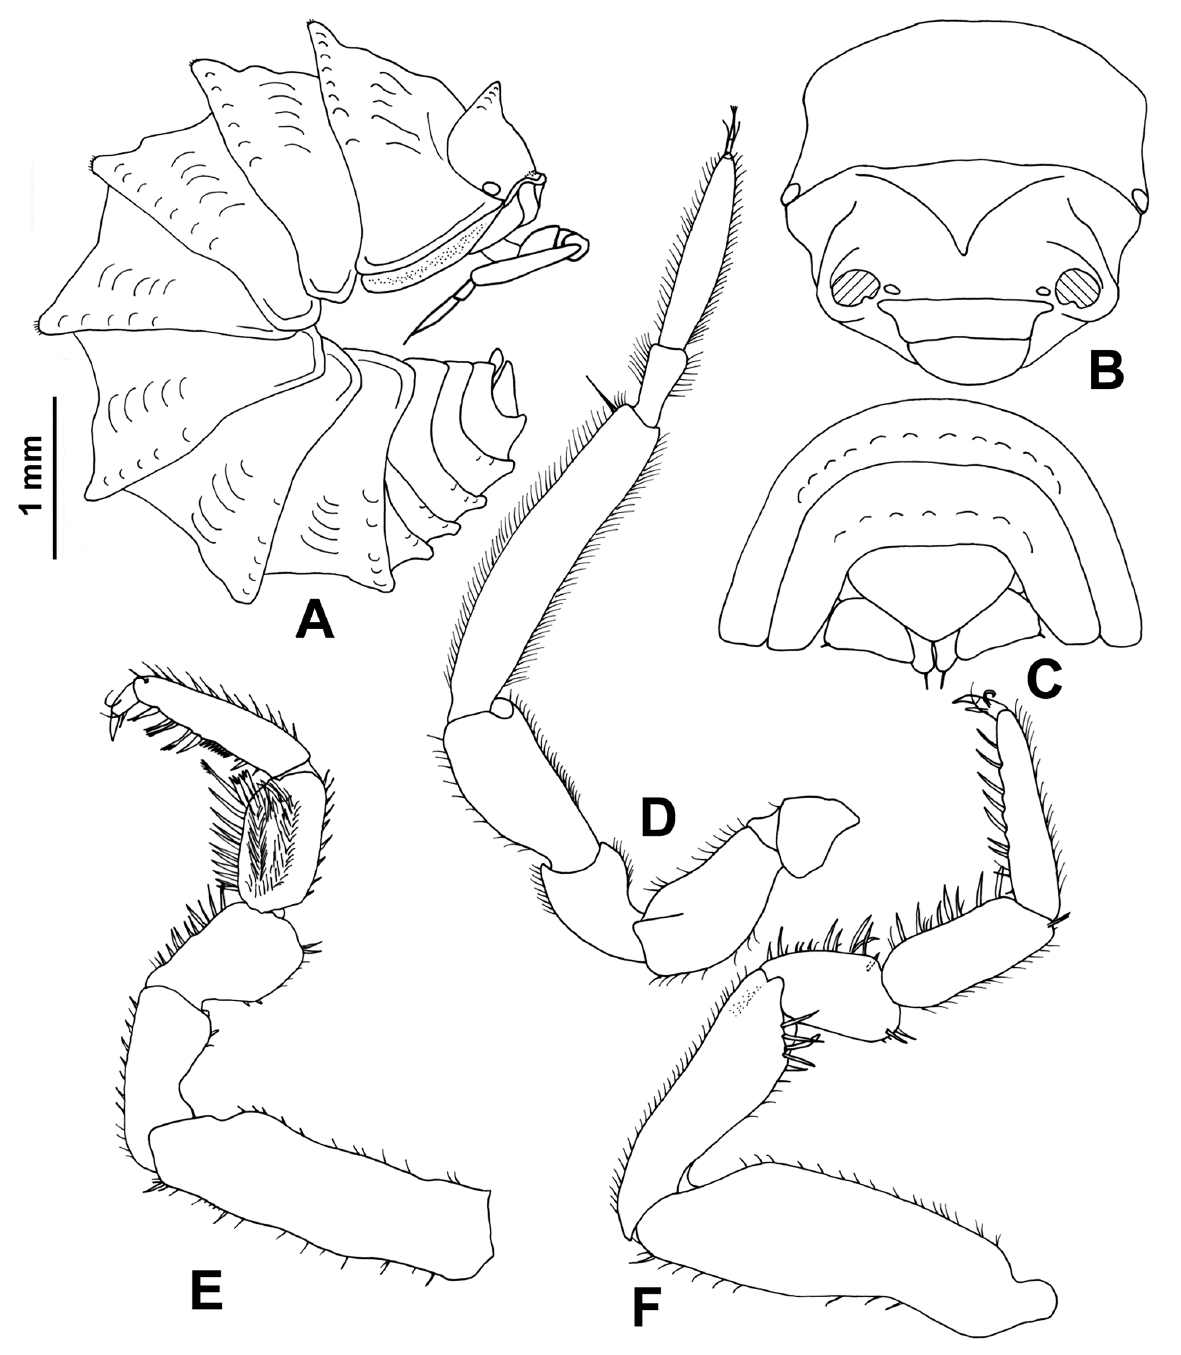
Fig. 30. Eluma tuberculata Cruz, 1991 from Gruta do Soprador do Carvalho, Sicó. — ♀. A . Specimen in lateral view. B . Cephalon in frontal view. C . Pleonites 4, 5, telson and uropods. — ♂. D . Antenna. E . Pereopod 1. F . Pereopod